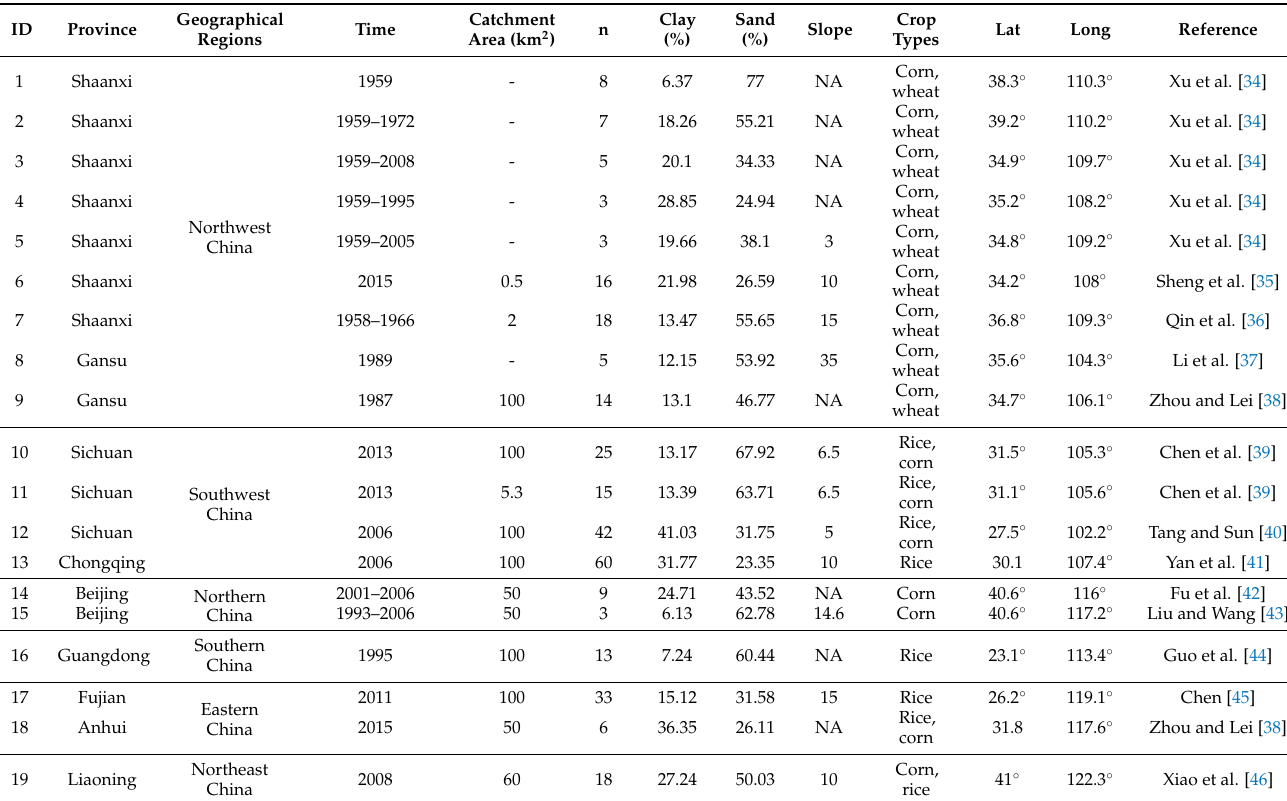
Table 1. Characteristics of 19 rainfall-runoff studied catchments in